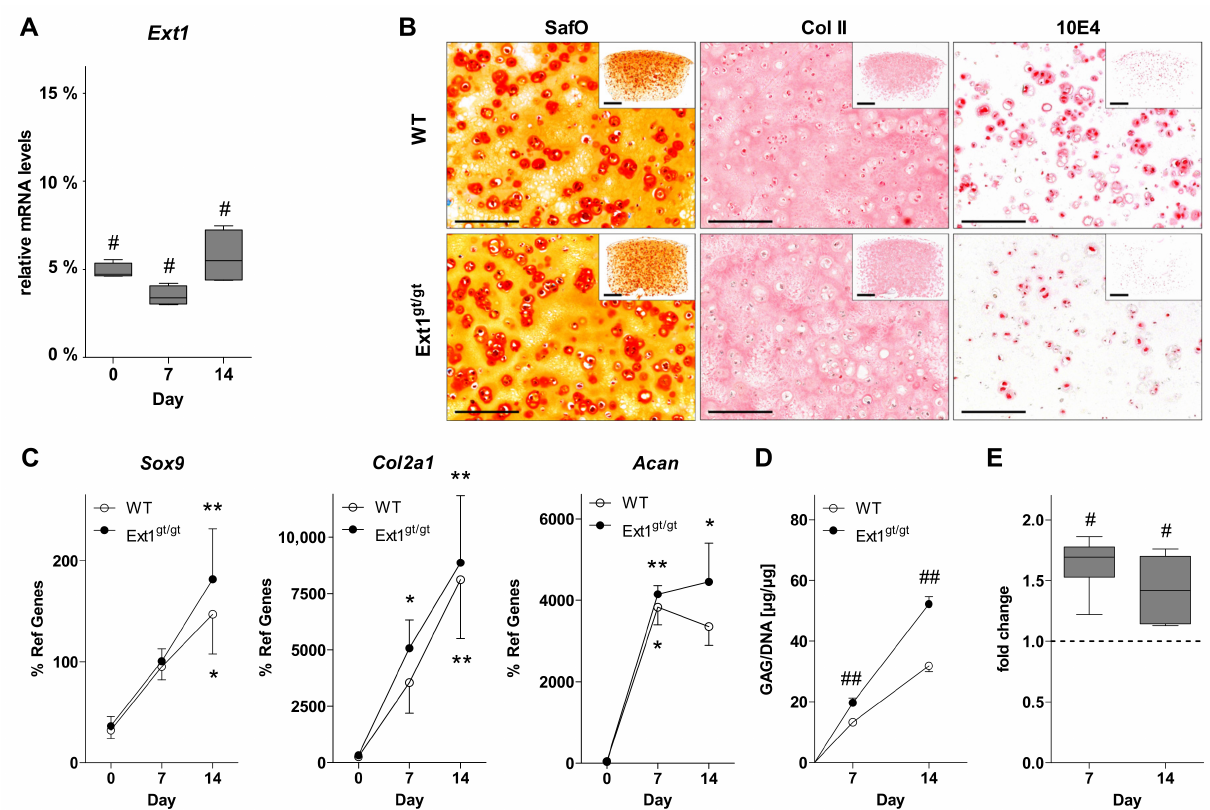
Figure 1. Characterization of Ext1 -hypomorphic engineered cartilage. Murine chondrocytes from E15.5 Ext1 gt/gt and wildtype (mice were differentiated at 5 × 10 5 cells per 25 µ L agarose construct for indicated time-periods under chondrogenic conditions. ( A ) Ext1 mRNA levels were determined by RT-qPCR and normalized to reference genes Rpl19 and Hprt with WT samples at the indicated timepoints set to 100%. Data are shown as box plots with each box representing the interquartile range and lines inside the boxes representing the median. Whiskers range from minimum to maximum values ( n = 4, 4 donors). ( B ) Paraffin sections of engineered cartilage on day 14 were stained with Safranin Orange/Fast Green to visualize glycosaminoglycan (GAG) deposition (SafO, n = 22–26, 12 donors) or by immunohistochemistry against Collagen type II (Col II, n = 13–16, 6 donors) and the heparan sulfate (HS)-specific epitope 10E4 (10E4, n = 9–10, 5 donors). Representative images are shown. Scale bar 200 µ m (Inlays 500 µ m). ( C ) Expression of differentiation markers during cartilage maturation was determined by RT-qPCR and normalized to reference genes Rpl19 and Hprt ( n = 5–6, 5–6 donors). ( D ) GAG-content of cartilage tissue determined by 1,9-dimethylmethylene blue (DMMB) assay was normalized to DNA-content ( n = 6, 3 donors). ( E ) GAG de-novo synthesis was determined by 35 S-sulfate incorporation over the last 24 h of differentiation culture. Values were normalized to DNA-content and values of WT cartilage were set to 1 ( n = 6, 3 donors). vs. d0: Kruskal–Wallis * p < 0.05, ** p < 0.01; Ext1 gt/gt vs. WT: Mann–Whitney U test # p < 0.05, ## p <